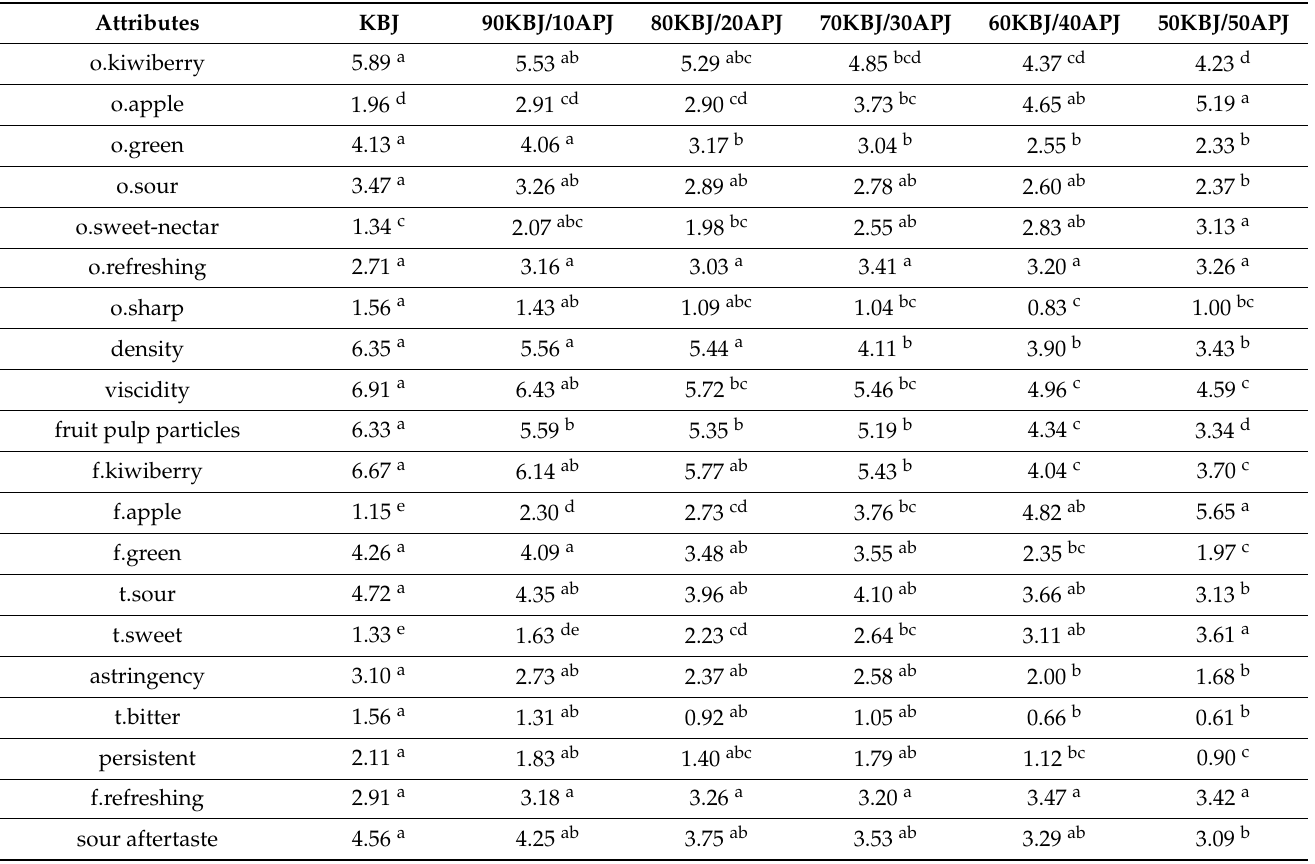
Figure 3. PCA plot of the similarities and differences in the profile of the volatile compounds identified in the headspace of kiwiberry, apple and pear juices and their mixes. Table 4. Sensory profiling of the kiwiberry juice and kiwiberry/apple juice